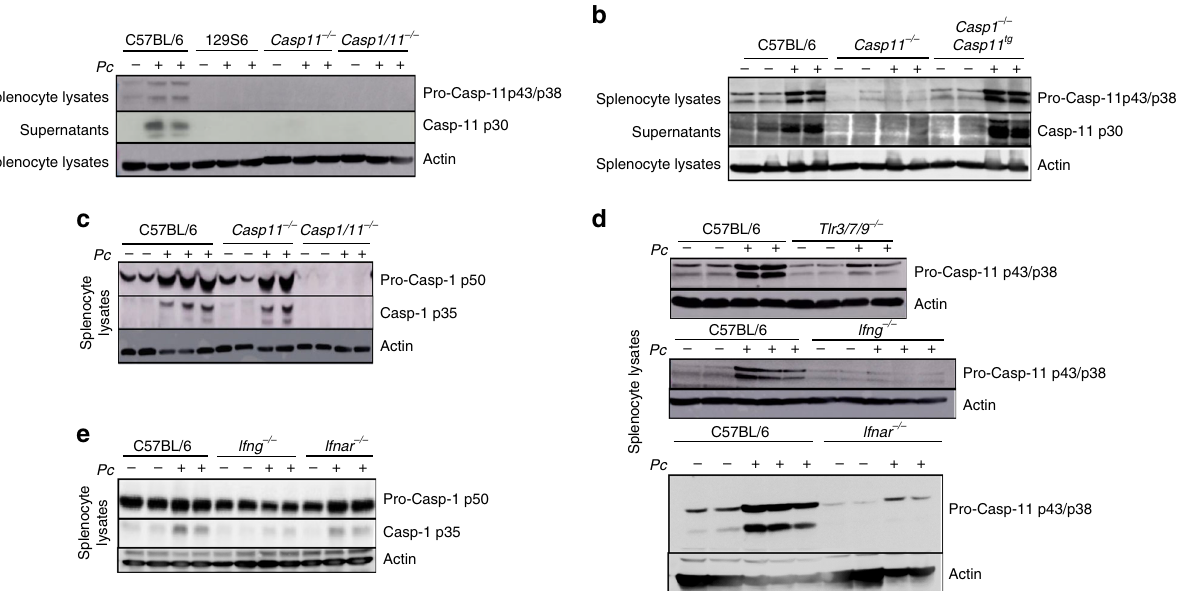
Fig. 1 Caspase-11 activation in P. chabaudi -infected mice. All results presented in this fi gure were obtained from mice either uninfected or at 8 days after infection with Pc , as indicated. a , b Splenocyte lysates and supernatants were obtained from C57BL/6, 129S6, Casp11 − / − , Casp1/11 − / − , and Casp1 − / − /11 tg mice, and analyzed by western blot using an anti-caspase-11 antibody. c Splenocyte lysates from C57BL/6, Casp11 − / − , and Casp1/11 − / − mice were analyzed by western blot using an anti-caspase-1 antibody. d Splenocyte lysates obtained from C57BL/6, Tlr3/7/9 − / − , Ifng − / − , and Ifnar − / − mice were analyzed by western blot using an anti-caspase-11 antibody. e Splenocyte lysates were obtained from C57BL/6, Ifng − / − , and Ifnar − / − mice and analyzed by western blot using an anti-caspase-1 antibody. Blots developed with an anti- β -actin were used as loading controls. All blots are representative of two to three different experiments with similar activated during malaria 18,42,43 . In rodent malaria, most splenic monocytes differentiate into in fl ammatory monocytes (iMOs,